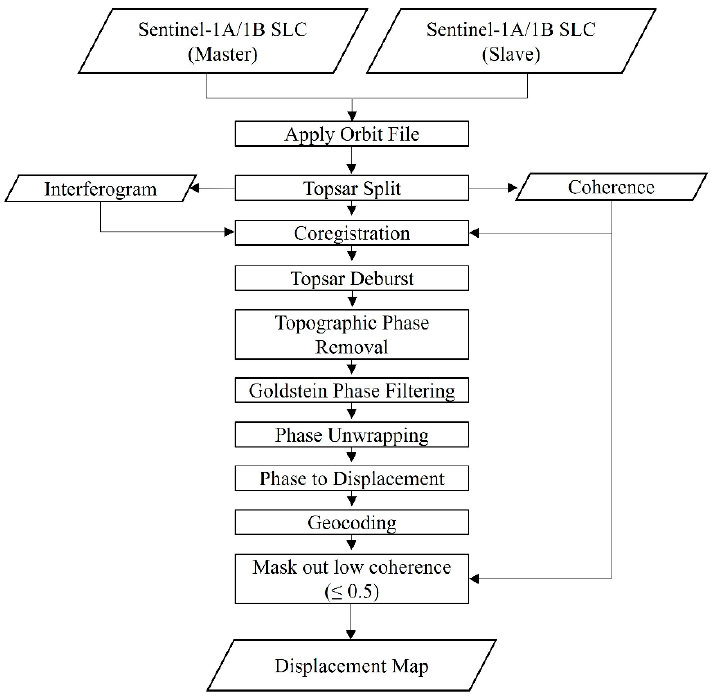
Figure 3. Methodology for this study. Table 1. List of Sentinel 1 Satellite imageries corresponding to earthquakes on 29 July 2018, 5